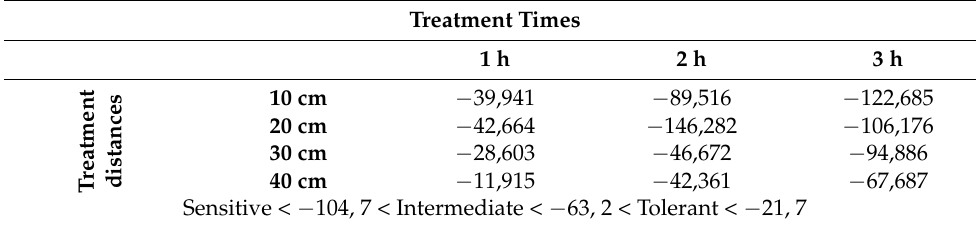
Figure 1. The effects of UV-B radiation on the main parameters of pollen grains. ( a ) Representative images of FDA/PI staining providing green fluorescence radiation for viable pollen grains and red fluorescence radiation for non-viable pollen grains; ( b ) Pollen viability rates (%) after 1, 2, and 3 h treatment at 10, 20, 30, and 40 cm distances; ( c ) Representative images of germinated pollen grains and pollen tubes; ( d ) Pollen germination rates (%) after 1, 2, and 3 h treatment at 10, 20, 30, and 40 cm distances; ( e ) Pollen tube lengths (µm) after 1, 2, and 3 h treatment at 10, 20, 30, and 40 cm distances. Different letters within the figures indicate statistically significant differences. Bar: 20 µm. Table 1. CSRI values of treatment